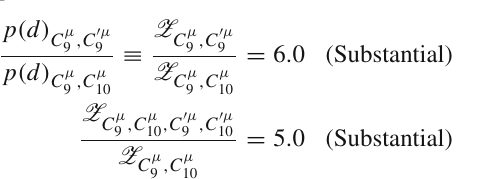
Fig. 2 a In green, the 1 σ (dark) and 2 σ (light) credible regions of the posterior pdf for the scan in the input parameters C Table 2), marginalized over the nuisance parameter. The red star marks the position of the best-fit point. The gray solid (dashed) line shows the